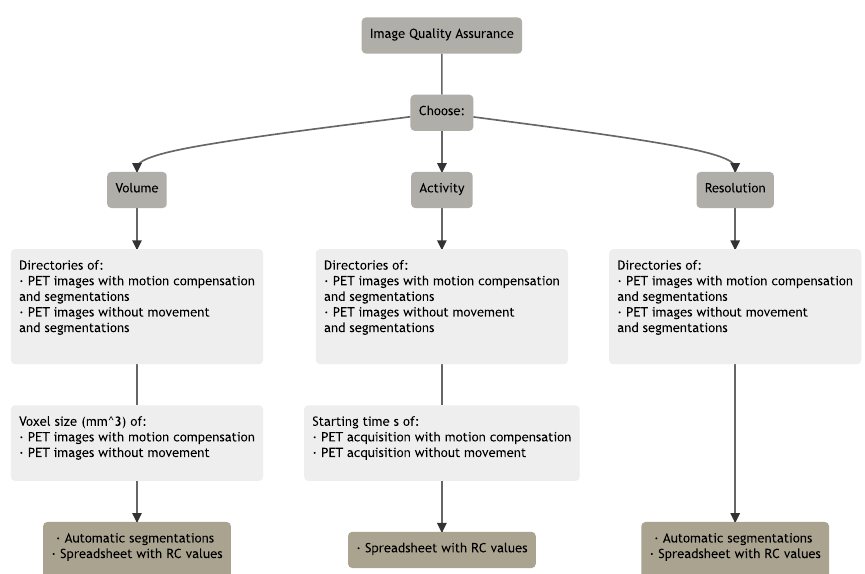
Fig. 6 Scheme for Image Quality Assurance workflow of the open‑source package. Light gray boxes indicate the inputs necessary for each type of quantification analysis. Brown boxes indicate the outputs of each analysis